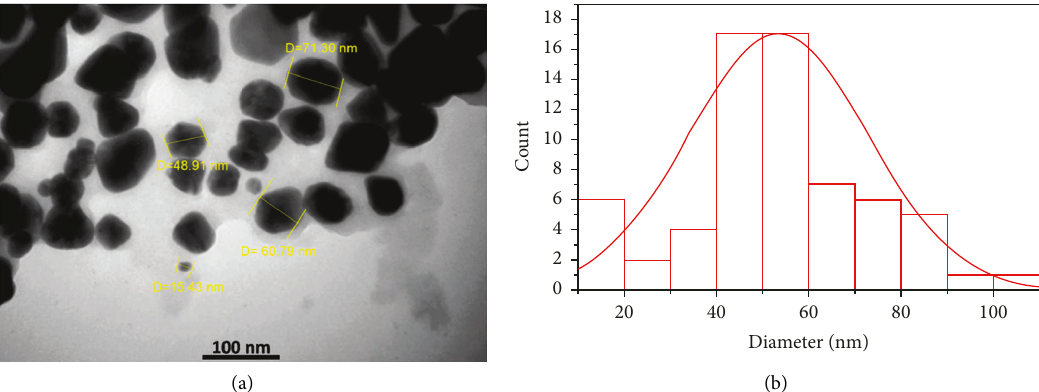
Figure 6: (a) TEM image showing spherical nanoparticles of AgNPs at the scale of 100nm and (b) the size distribution of green synthesized silver nanoparticles.